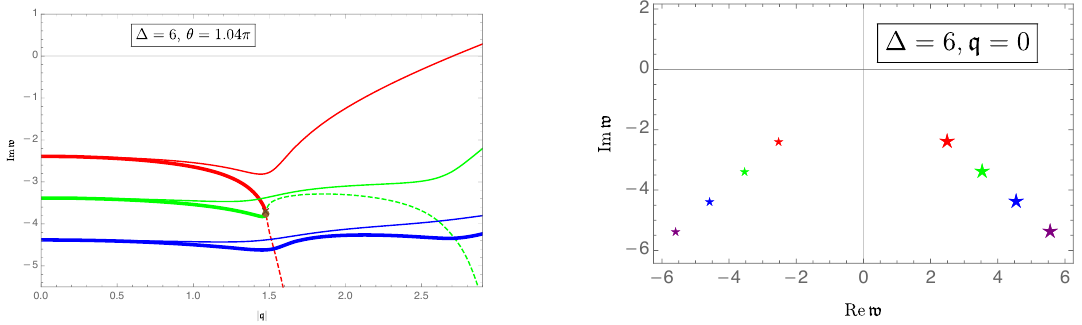
Figure 11 . Left panel: dispersion relations of the lowest three QNMs at ∆ = 6 and q 2 = | q 2 | e iθ with θ = 1 . 04 π . Right panel: spectrum of the lowest three QNMs at ∆ = 6 and q = 0 . The brown cross-dot in the left panel shows exactly the brown cross-dot marked in figure 4. Thick curves in the left panel correspond to the big stars on the right side of the right panel. Dashed curves in the left panel show the dispersion of the modes after the